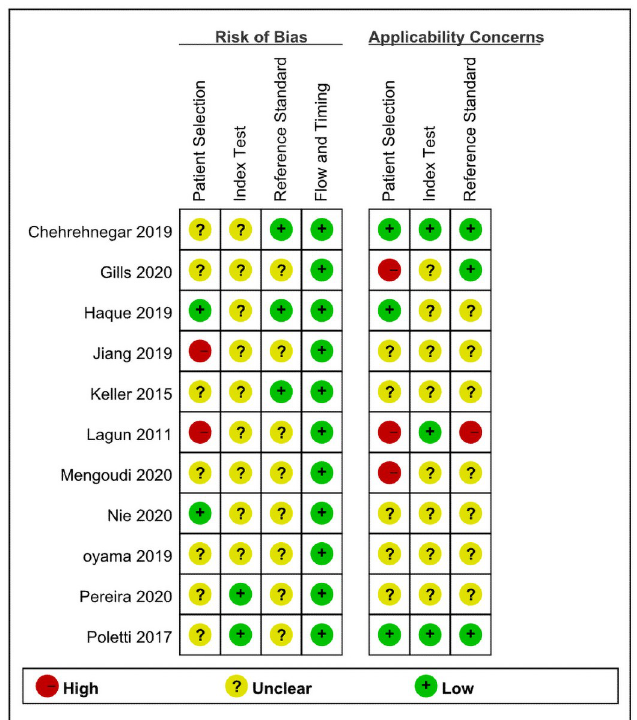
Fig 3. Risk of bias and applicability